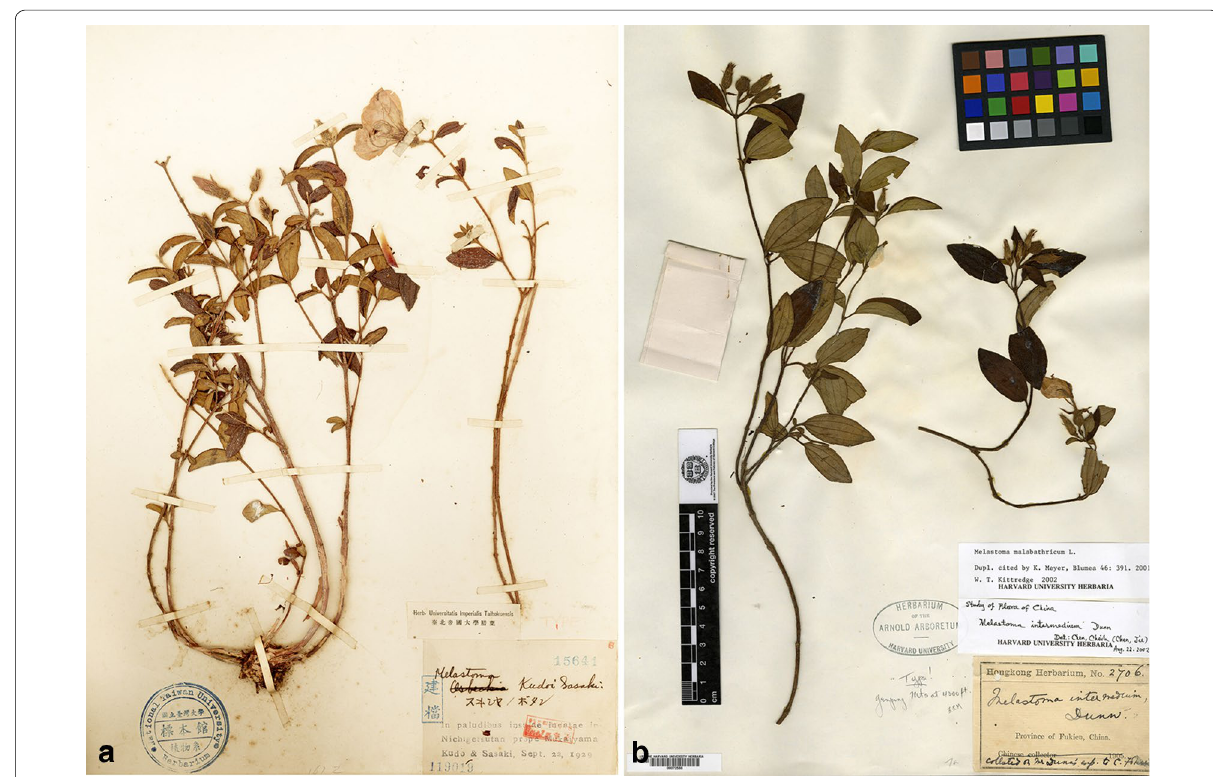
Fig. 1 a Taiwan, Lake Sui‑sya, Kudo & Sasaki s.n. (TAI), type of Melastoma kudoi Sasaki, image from TAI Herbarium; b China, Fujian, Yenping, Dunn 2706 (A), isotype of Melastoma intermedium , image from